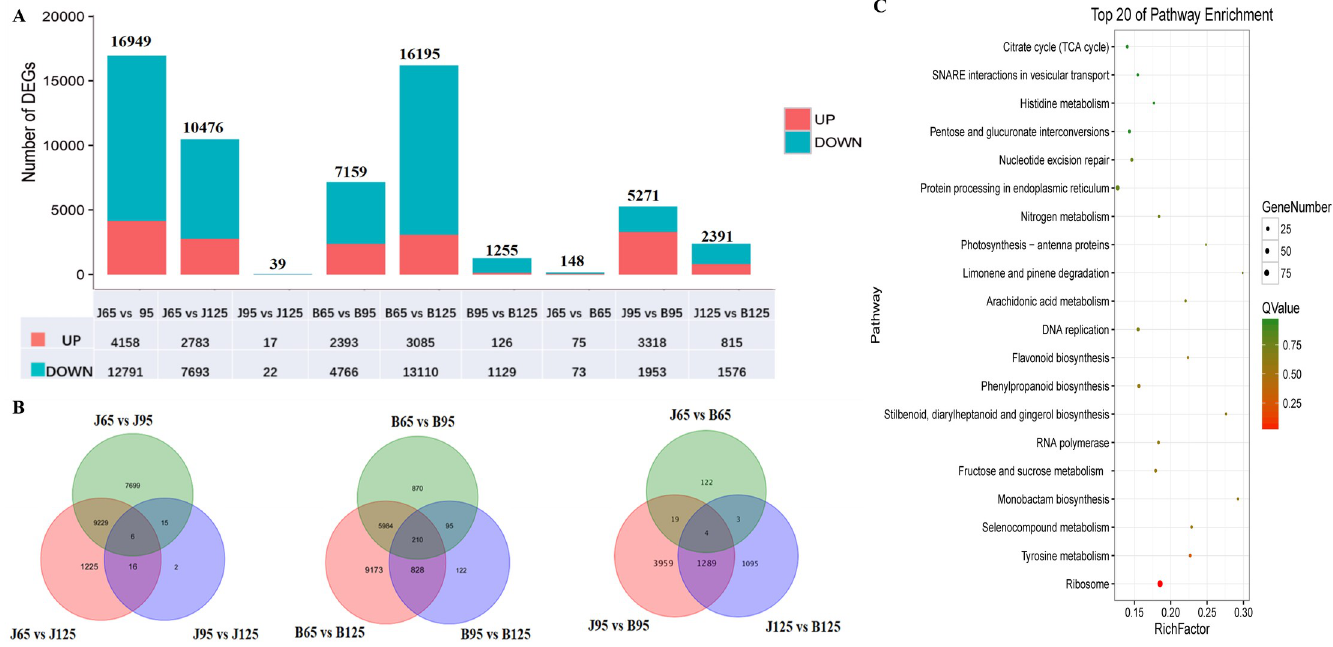
Fig 3. Analysis of differentially expressed genes between JFZ and BL. The number of differentially expressed genes between different samples (A). The Venn diagram showed the number of unigenes expressed in all three developmental stages of both cultivars (B). The top 20 enriched KEGG pathways were sorted by P-value for DEGs between the two cultivars at 125 DAF